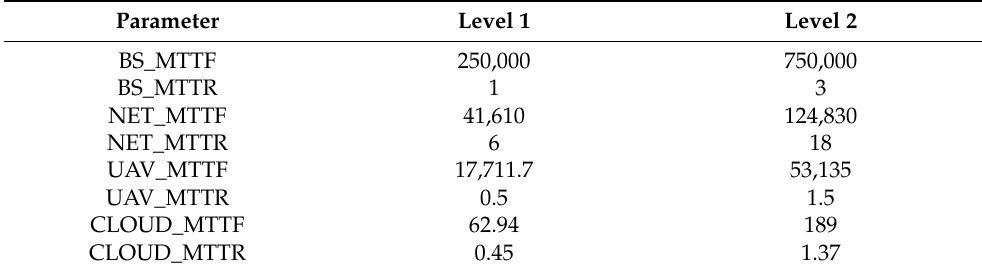
Table 2. Factors and respective